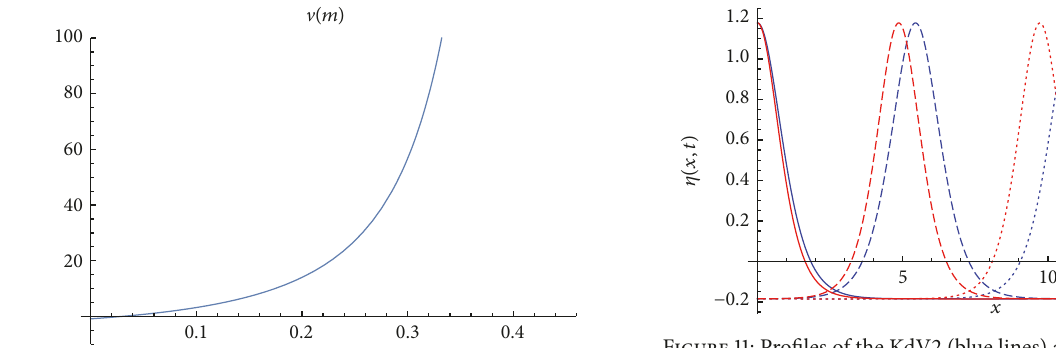
Figure 11: Profiles of the KdV2 (blue lines) and KdV solutions (red lines) for 𝛼 = 𝛽 = 0.3 and 𝑚 = 0.99 . Solid lines correspond to 𝑡 = 0, 𝑇 , dashed lines to 𝑡 = 𝑇/3 , and dotted lines to 𝑡 = 2𝑇/3 , respectively ( 𝑇 is the wave period).